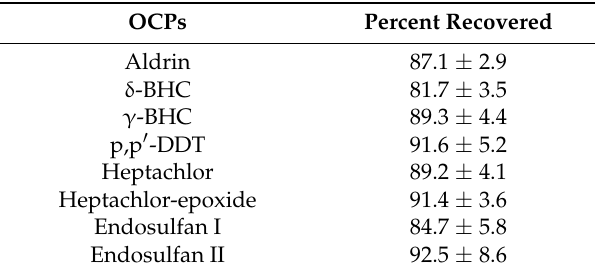
Table 1. Mean percent recovery for the